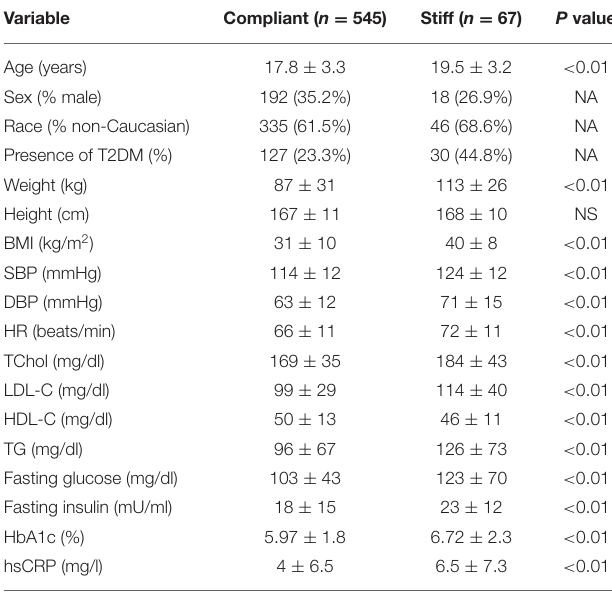
TABLE 1 | Demographics and metabolic profile of study participants stratified by Global Stiffness Index category ( n = 612, mean ± SD or